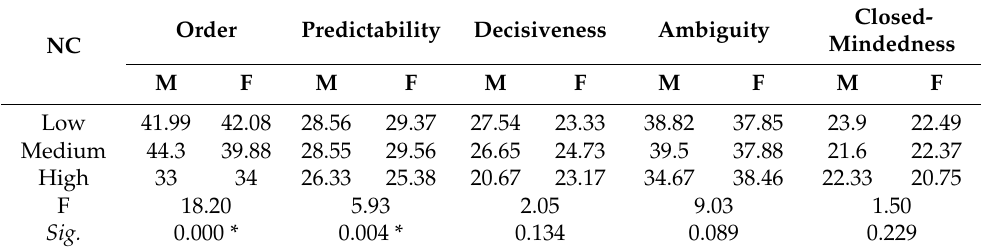
Table 1. Average scores for the five factors of the test for the need for cognitive closure in the participants (with the exception of those exceeding 15 on the lie scale) classified according to the quartiles of narrative creativity and gender.